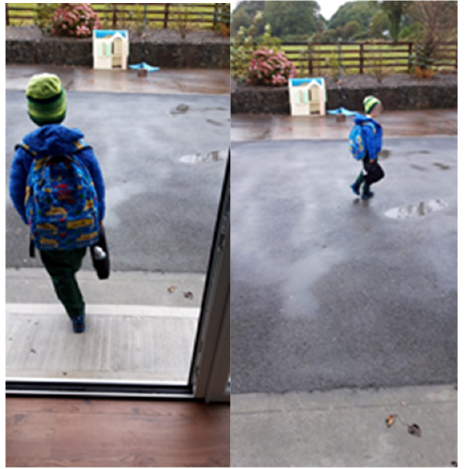
Figure 4. David on his way to school.